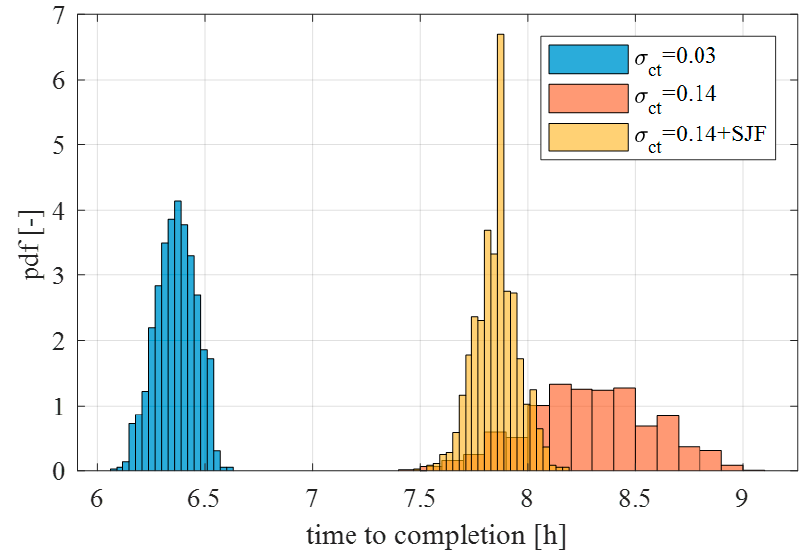
ff erent levels of cycle-time